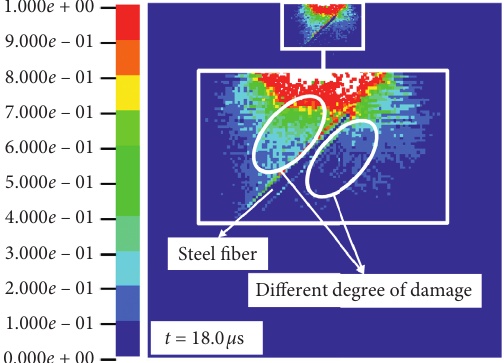
Figure 4: Crack appearance along the steel fiber.